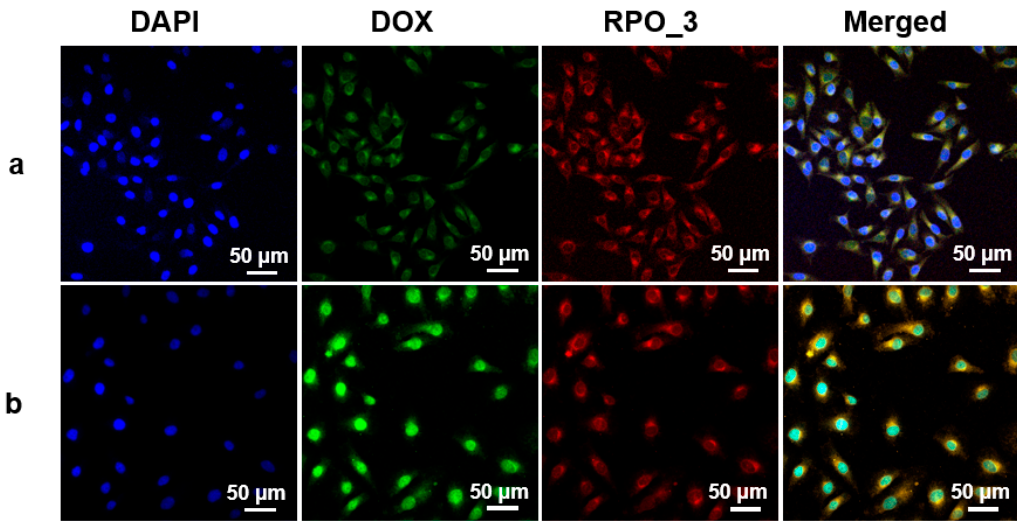
Figure 4. Fluorescence images of HeLa cells after being incubated with DOX@RPO-3 NPs over different ( a ) after 2 h incubation and ( b ) DOX@RPO-3 NPs after 12 h incubation, respectively. The fluorescence of 4 ′ , 6-diamidino-2-phenylindole (DAPI) ( λ ex = 405 nm), DOX ( λ ex = 488 nm, λ em = 495–550 nm), and RPO-3 ( λ ex = 488 nm, λ em = 600–700 nm) was pseudo labeled with blue, green, and red, respectively.